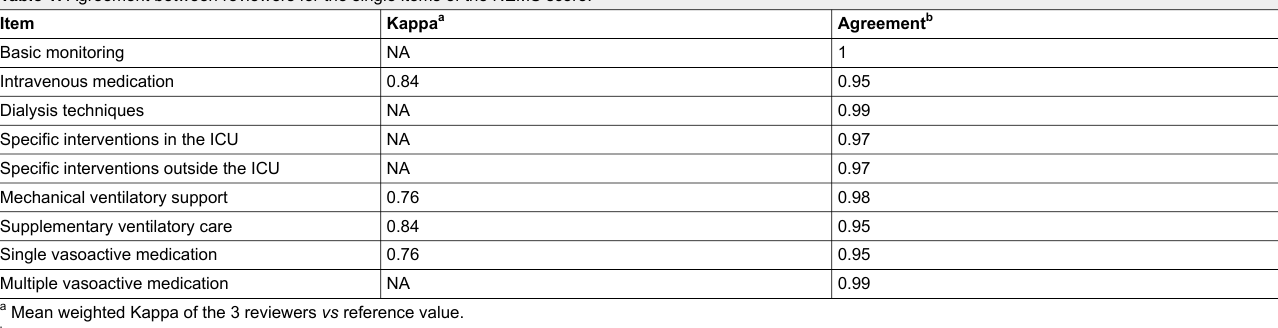
Table 1: Agreement between reviewers for the single items of the NEMS score.